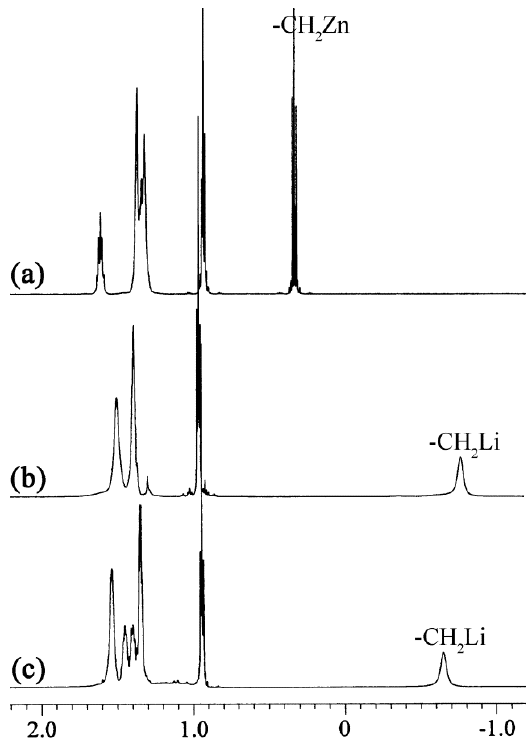
Figure 1. 1 H NMR spectra of: ( a ) (1-Octyl) 2 Zn; ( b ) Commercial source of 1-hexyllithium; ( c ) 1-Octyllithium generated from (1-octyl) 2 Zn.